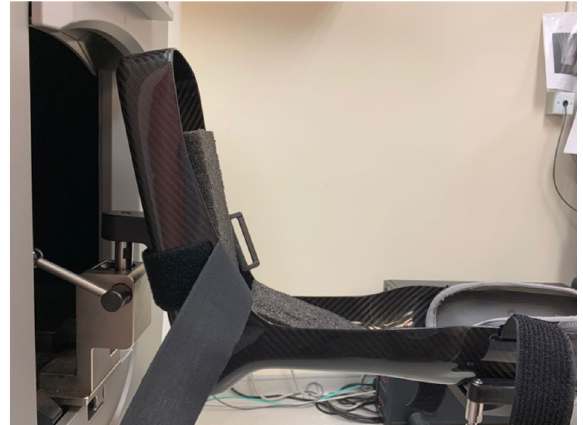
Figure 1. The wedge was put at the end of the splint to support the foot.